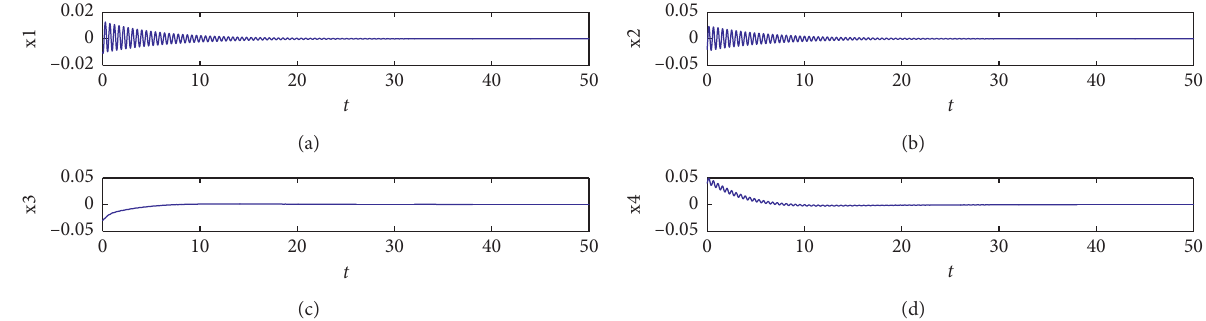
Figure 9: Asymptotical stabilization of the fractional-order novel hyperchaotic system (37) with α � 1.15 and feedback gain K � (2, − 8, − 3.5, − 1).